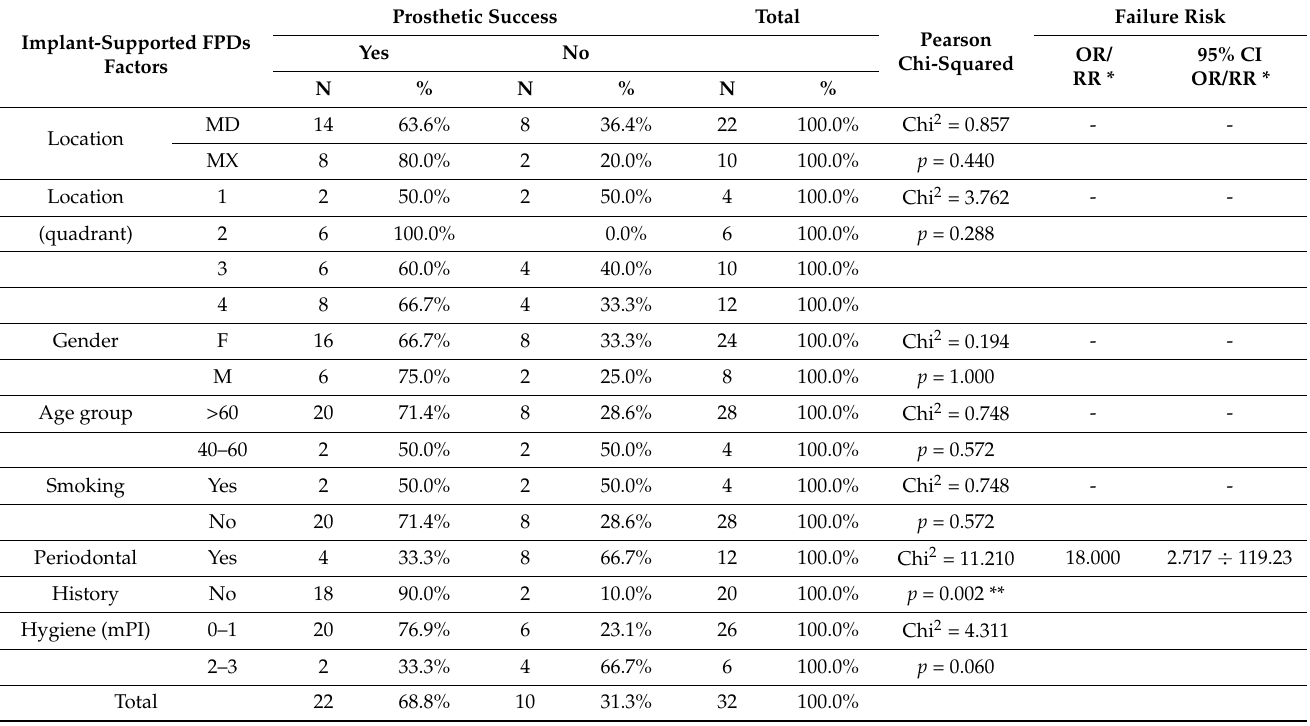
Table 7. Implant-supported FPDs: failure risk factors.